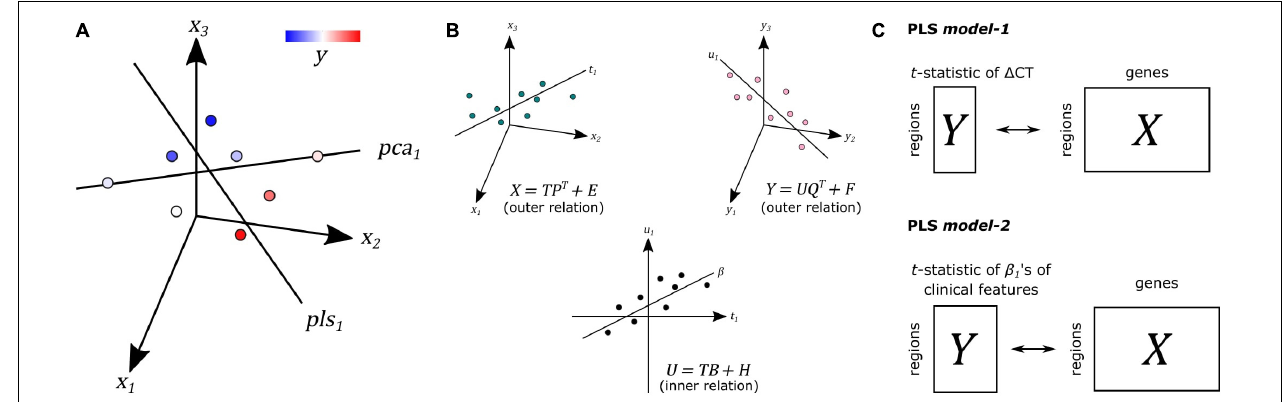
FIGURE 1 | Principal of partial least squares regression (PLS). (A) Principal component analysis (PCA) and PLS project measurements to a new latent space. Unlike PCA, PLS tries to find a latent space that is maximally correlated with another measurement y from dataset Y on the same samples. (B) The first latent component t 1 of dataset X is maximally correlated with the first latent factor u 1 of dataset Y . T and U scores determine the outer relations of individual datasets in the model. The coefficient β determines the inner relation between both datasets X and Y in the model (more details in Supplementary Methods ). (C) In PLS model-1 , we used regional gene expression as input to predict the regional t -statistics of (cid:49) CT. Given the PLS model, R in Eqs. 5 and 6 in Supplementary Methods is used as gene weights. In PLS model-2 , we used the same input to predict the t -statistics of correlation coefficients β 1 of clinical features from Eq.